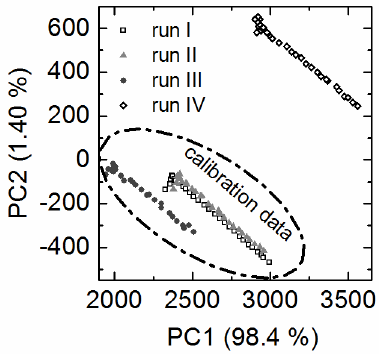
Figure 1. PCA scores plot. The EEM raw data was used as input for the PCA. The PCA scores plot shows the differences between the four batch cultivations with EnPresso ® B medium. For clarity only every tenth point is shown. The circle indicates the cultivations used for PLS model calibration and run IV was used as test dataset to predict the target parameters. The cultivation run IV was carried out with six months time lag to the other cultivations.